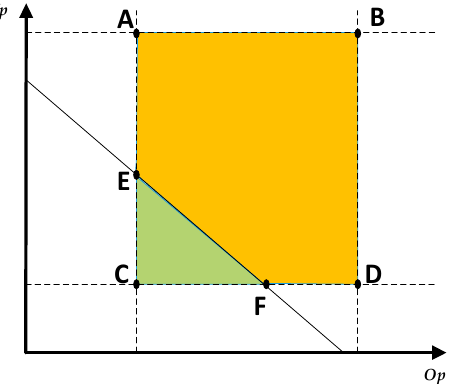
Figure 5. Schematic diagram of impacts of 𝑁𝑃𝑃 on energy storage’s selection in power plants.